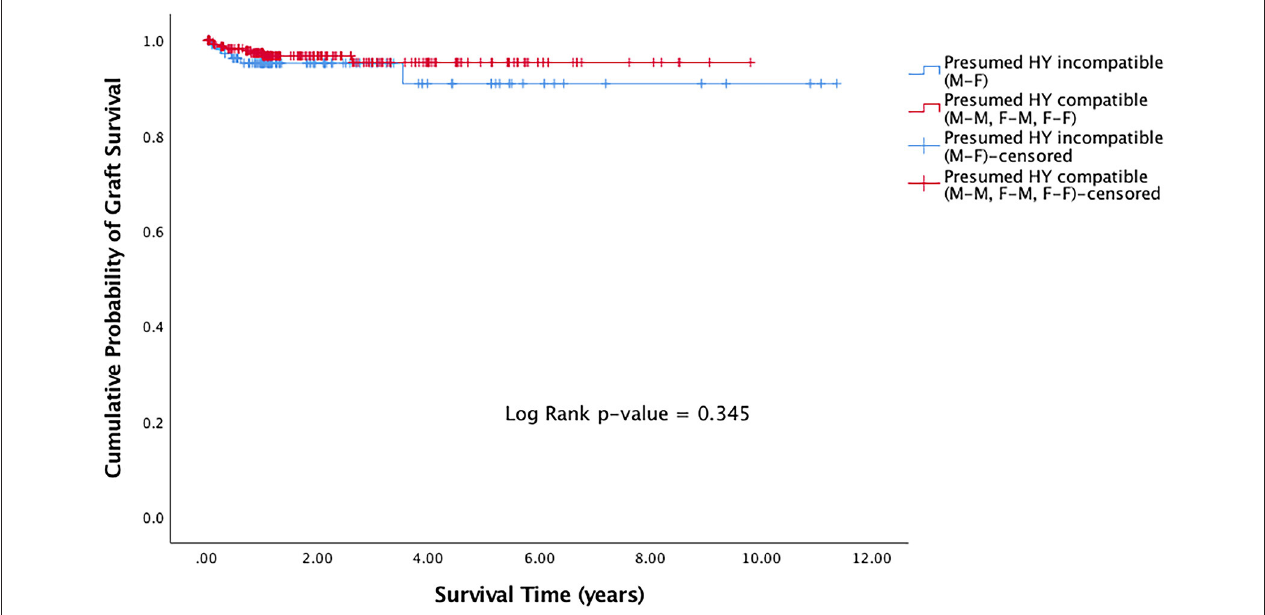
FIGURE 2 | Kaplan Meier rejection-free survival curve for presumed H-Y incompatible and H-Y compatible grafts.